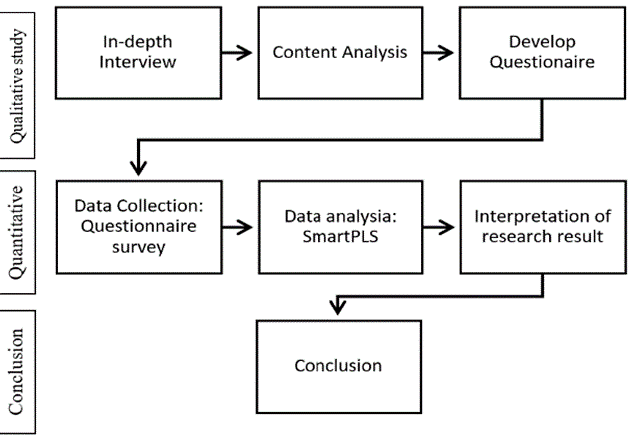
Figure 5. Methodology for doing research utilising a sequential exploratory approach.